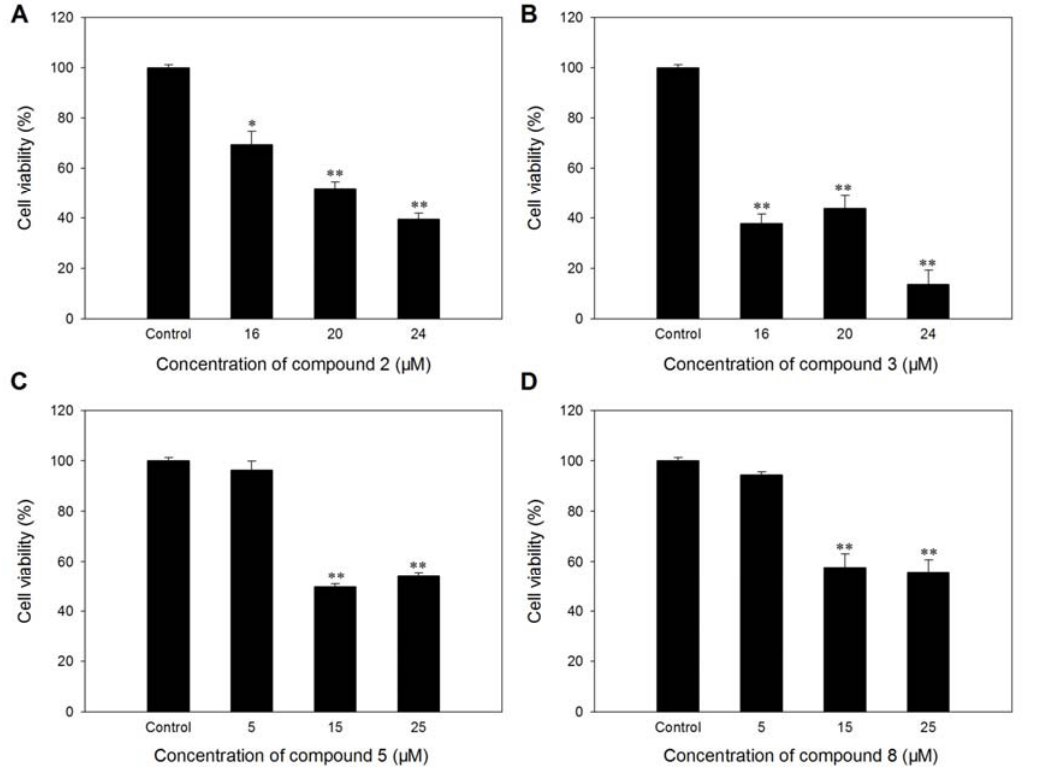
Figure 5. Effect of compounds 2 ( A ), 3 ( B ), 5 ( C ), 8 ( D ) on the viability of HUVEC after 48 h incubation. For blank control, the DMSO concentration was adjusted to below 0.1%. Values are expressed as mean ± SD, n = 4–6. * p < 0.05, ** p < 0.01 as compared with control.